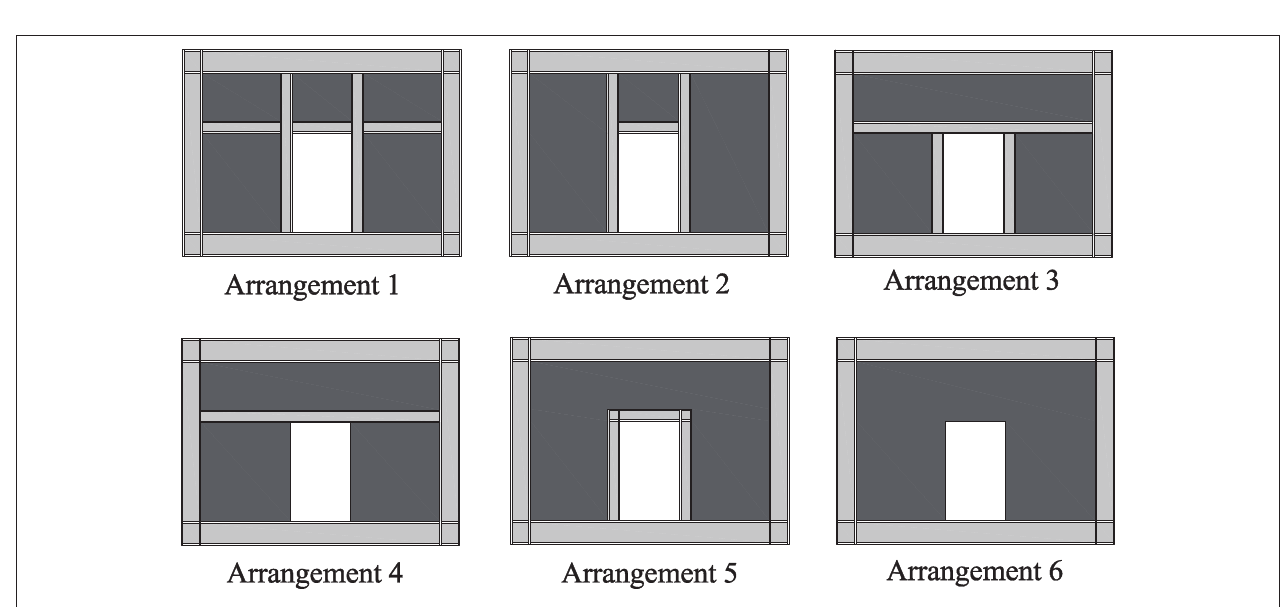
FIGURE 3 | Different arrangements of stiffeners around the door